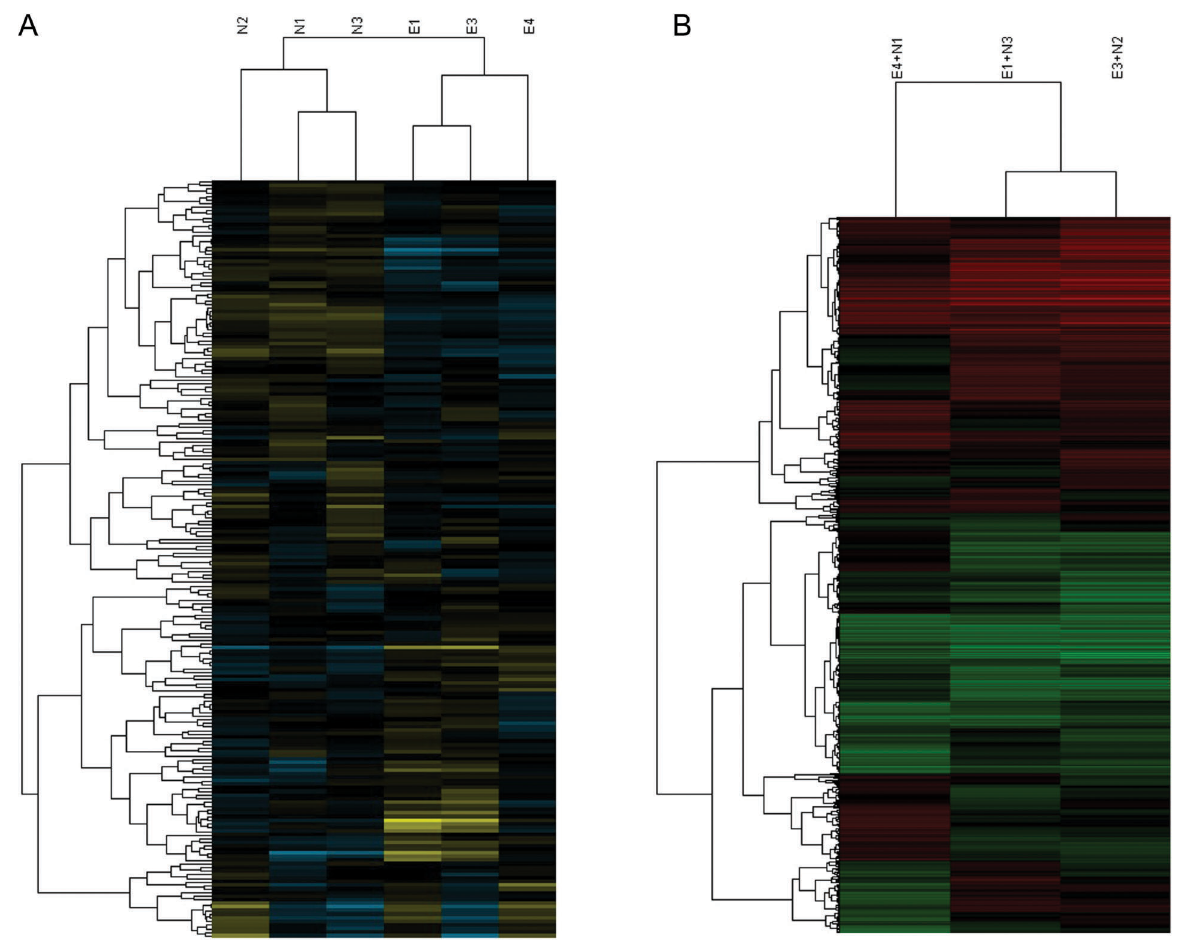
Figure 3. Hierarchical clustering of differentially expressed microRNAs ( A ) and mRNAs ( B ) between Hep-2 and Hep-2/v